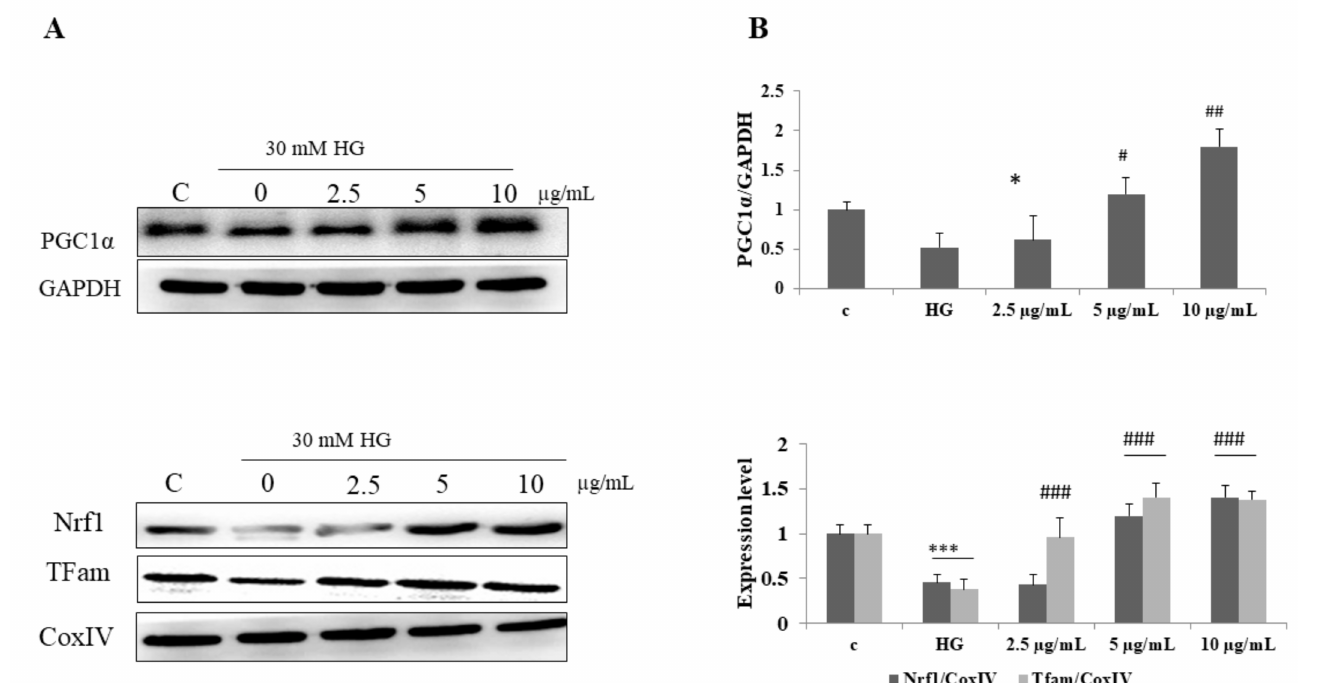
Figure 7. Effect of DI-10 on mitochondrial biogenesis pathway protein expression under high-glucose conditions. ( A ) DI-10 improves the expression of mitochondrial biogenesis-regulating factors in myotubes in high-glucose conditions through NRF-1 and TFam. ( B ) Graph showing densitometric analysis. *** p < 0.001 and * p < 0.05 compared to control and ### p < 0.001, ## p < 0.01 and # p < 0.05 compared to the high